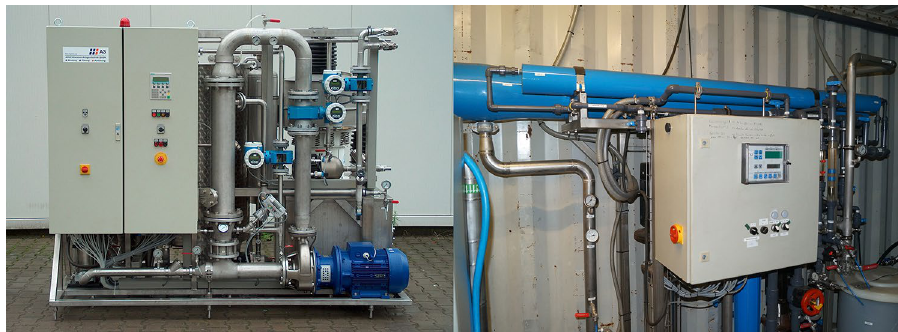
Fig. 3 Installed membrane equipment, left: ultrafiltration unit; right: reverse osmosis units II and